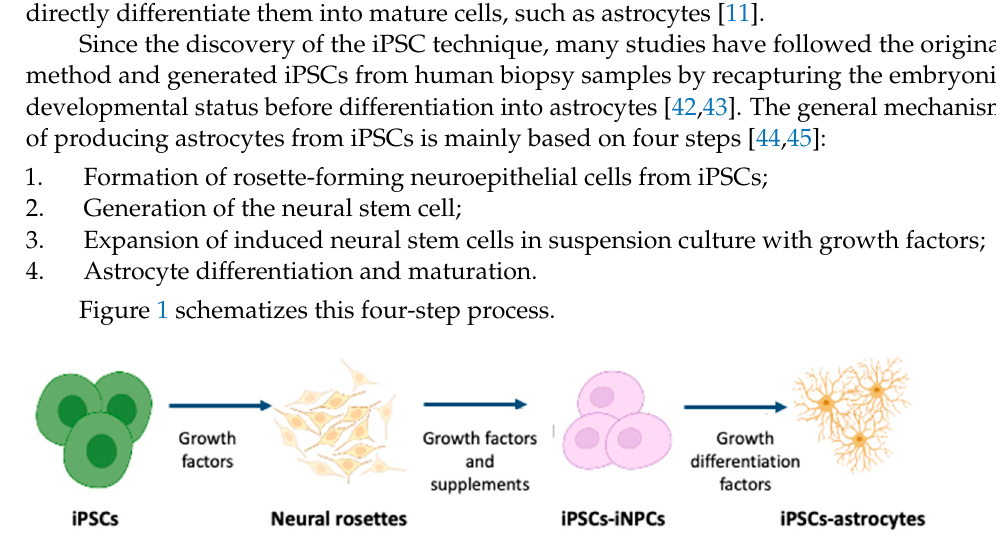
Figure 1. Schematic steps for differentiation of iPSC to astrocytes.